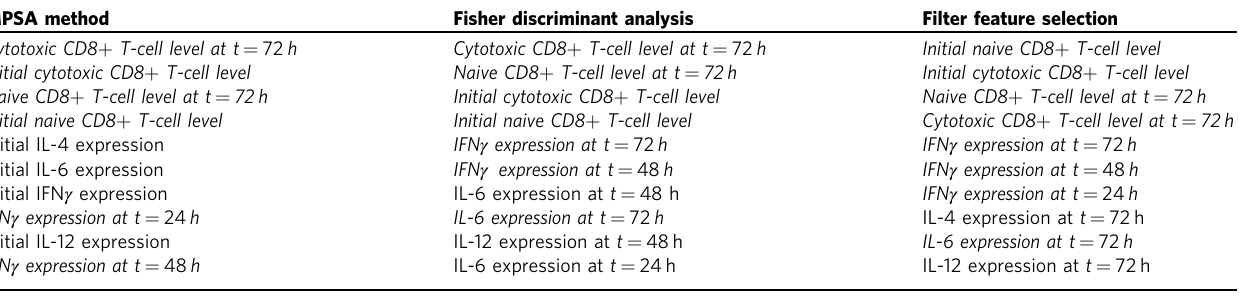
Table 2 Top 10 experimentally-accessible response features selected by the MPSA method, Fisher discriminant analysis, and fi lter feature selection for distinguishing responder and non-responder phenotypes to anti-PD-1 immunotherapy.